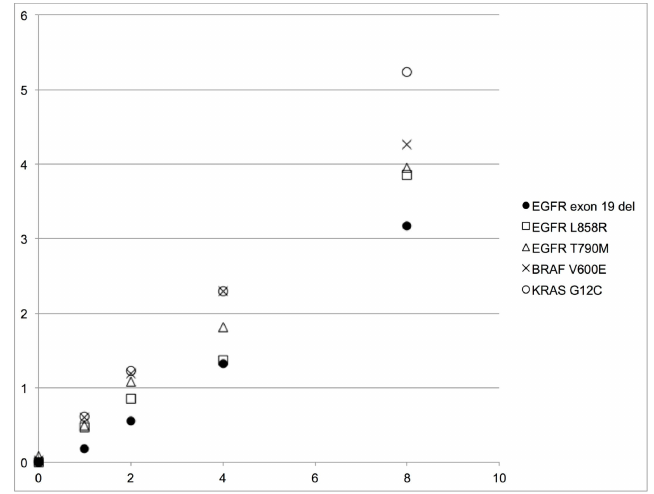
Figure 2. Quantitative ability of DNA module I. Horizontal axis, mutation allele frequency of artificial DNA (%); vertical axis, mutation allele frequency measured with the compact panel (%). Each data point is an average of eight samples.